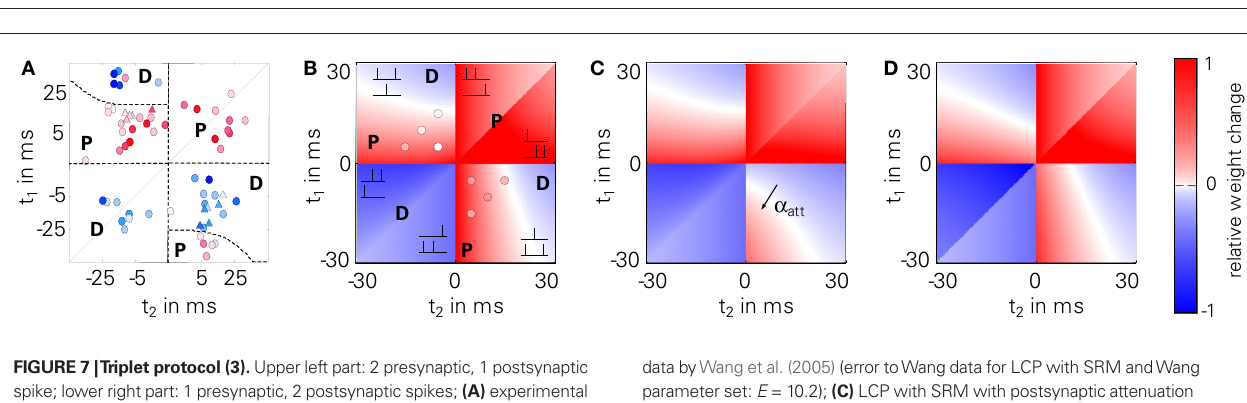
FigurE 6 | Correlated rate protocol (7); (A) standard nearest-neighbor STDP; (B) LCP with SrM without and with attenuation ( α Sjöström parameter set (see Table 4). Error without attenuation: E = 3.2. Error bars denote experimental data by Sjöström et al. (2001).